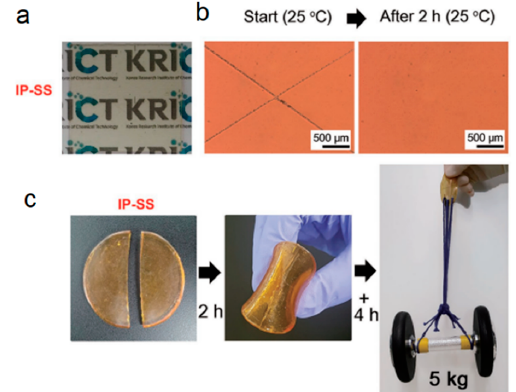
Figure 5. Healing illustration of self-healing polyurethane based on the combination of disulfide bonds and shape memory effect.